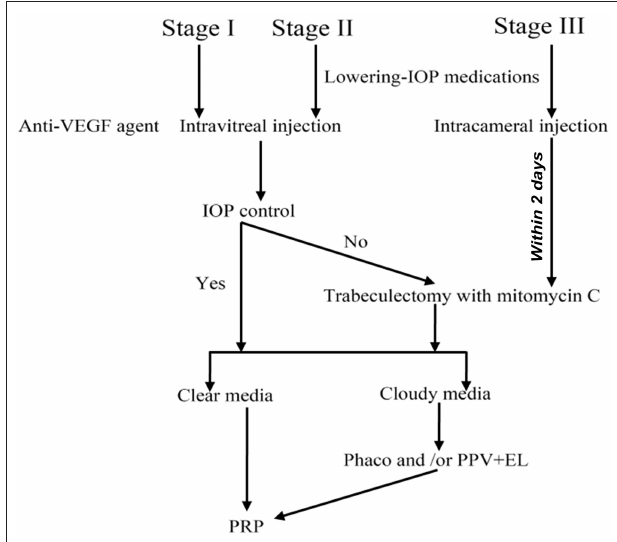
FIGURE 2 | The optimized therapeutic regimen for neovascular glaucoma. Phaco, Phacoemulsification; PPV, Pars plana vitrectomy; EL, Endolaser; PRP, Pan-retinal photocoagulation.